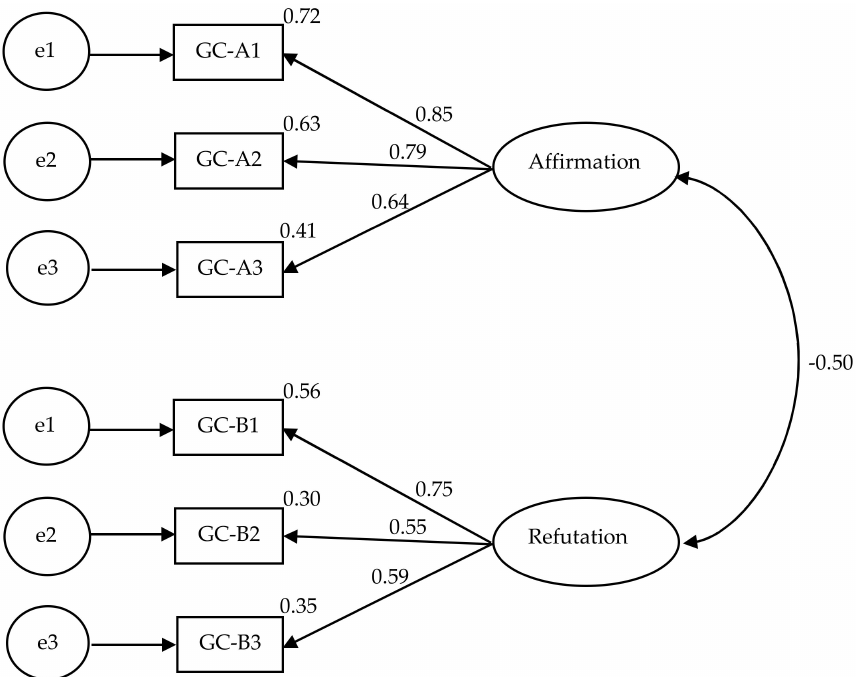
Figure 2. Results of confirmatory factor analysis showing items’ loadings for a two‑factor model for Goal Ambivalence Scale based on data from Study